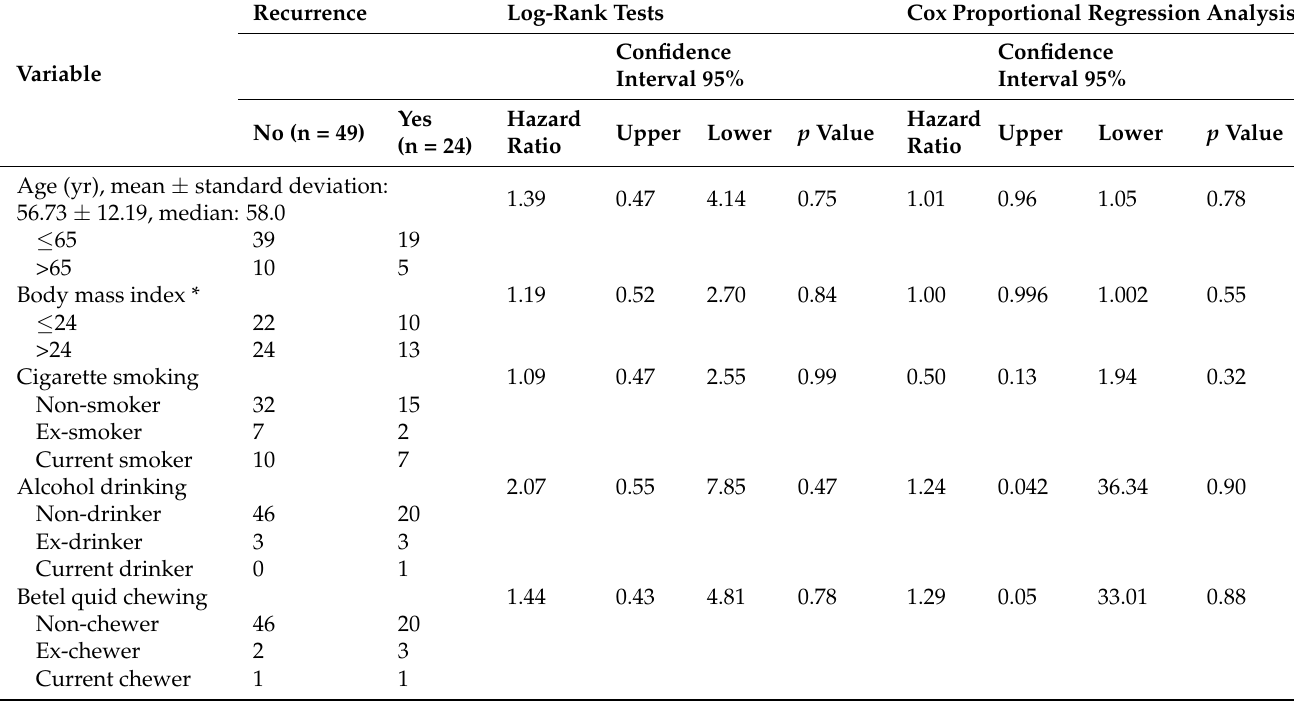
Table 3. Log-rank tests and Cox proportional regression analysis of postoperative recurrence (n = 24) in female patients who received laser surgery for oral leukoplakia (n =